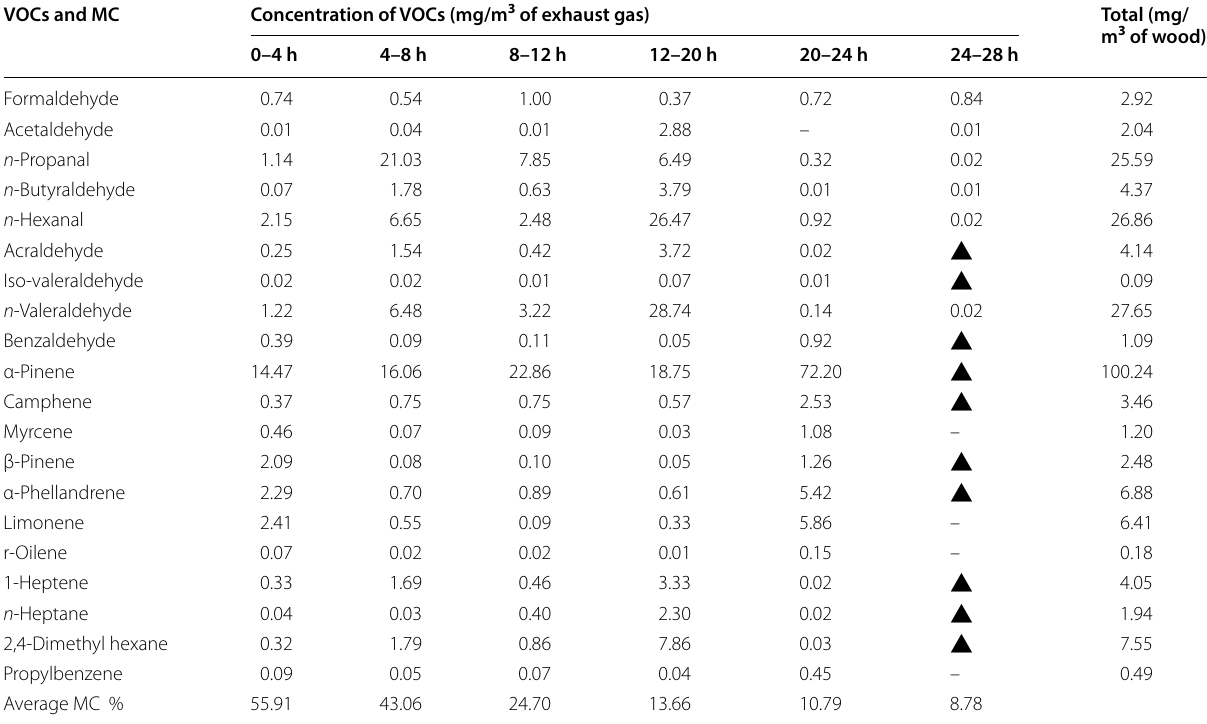
“–” indicates VOCs undetectable. “ ▲ ”indicates VOCs were detected, but less than 0.005 mg. This also applies to the following tables